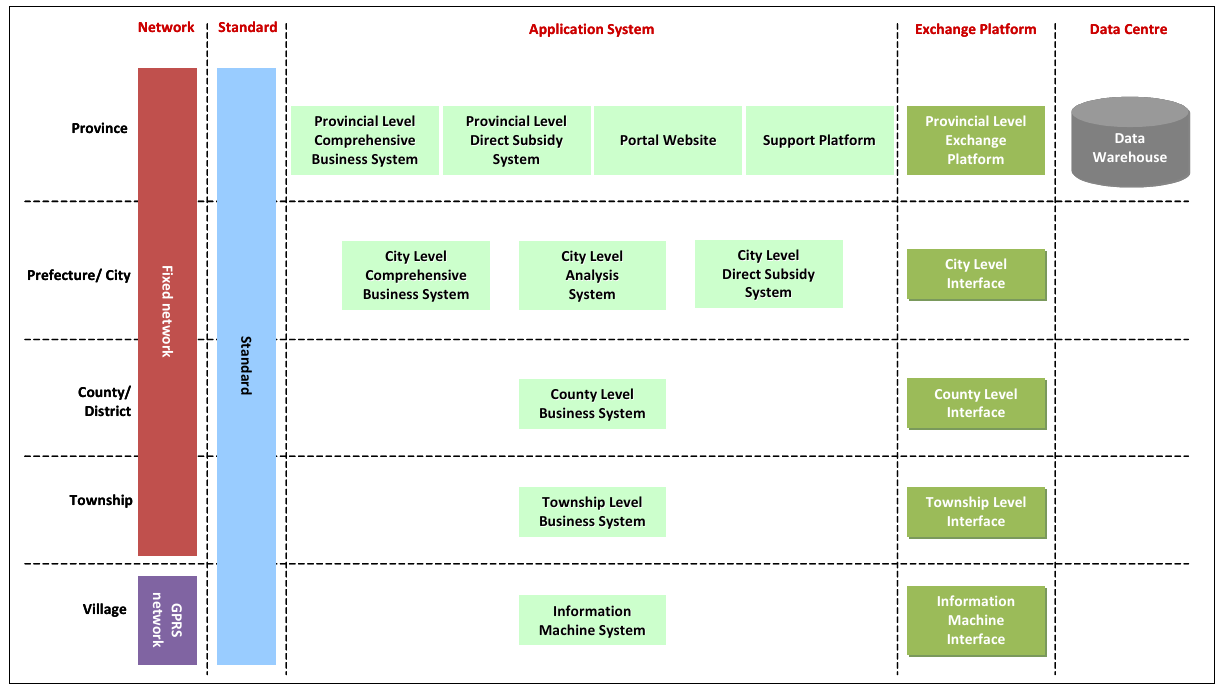
Figure 24: System specification for new rural cooperative IT and communications support